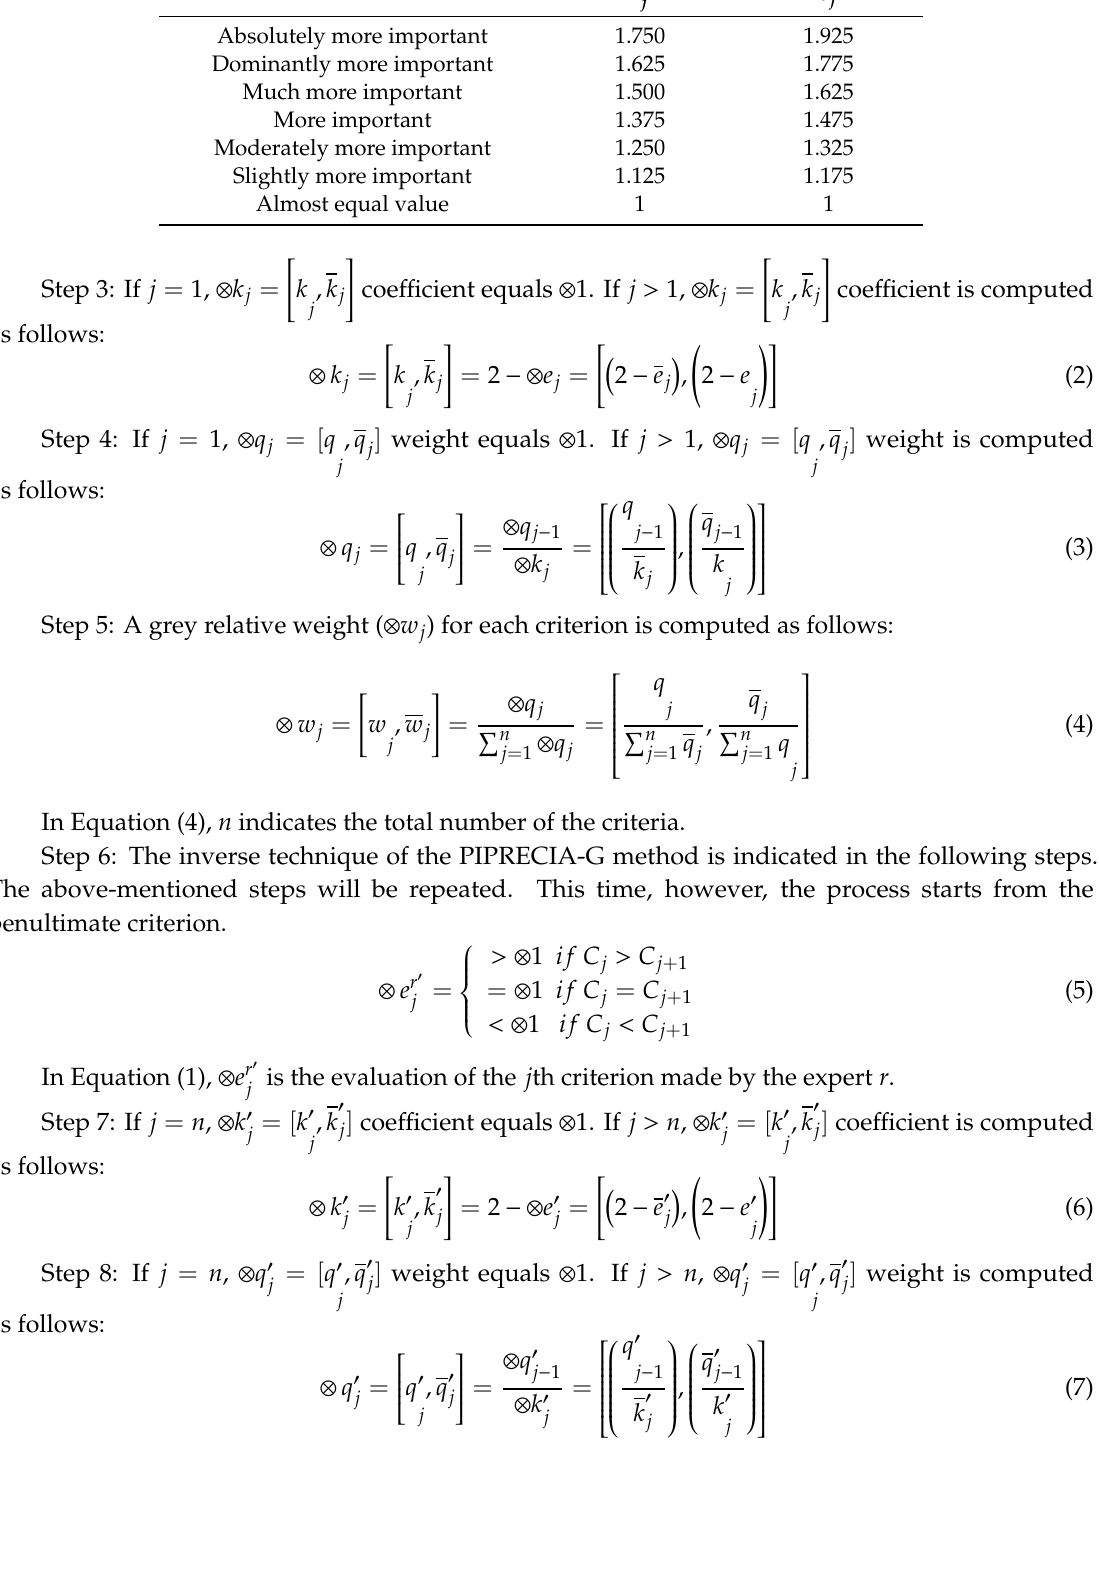
Table 2. The 1–2 scale for the evaluation of the criteria (adapted from Stevi´c et al. [33]). Linguistic Values Absolutely more important Dominantly more important Much more important More important Moderately more important Slightly more